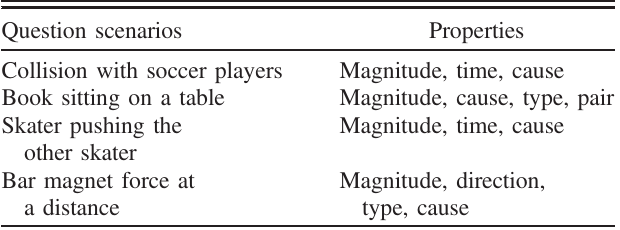
TABLE I. Question contexts defined by scenario and N3L properties